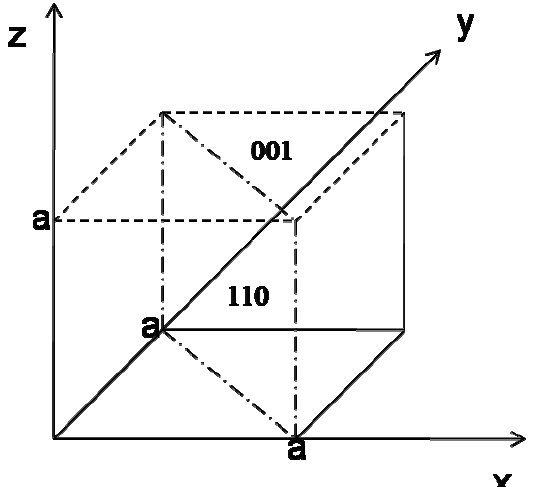
Fig. 1 Illustration of the miller indices of crystal faces of a cubic crystal. The “ short dash ” ( ─ ) plane (001) meets the x, y and z axes at infinity, infinity and a, respectively. The “ long dash dotted ” ( ─ . ─ . ─ ) plane (110) meets the x, y and z axes at a, a and infinity,